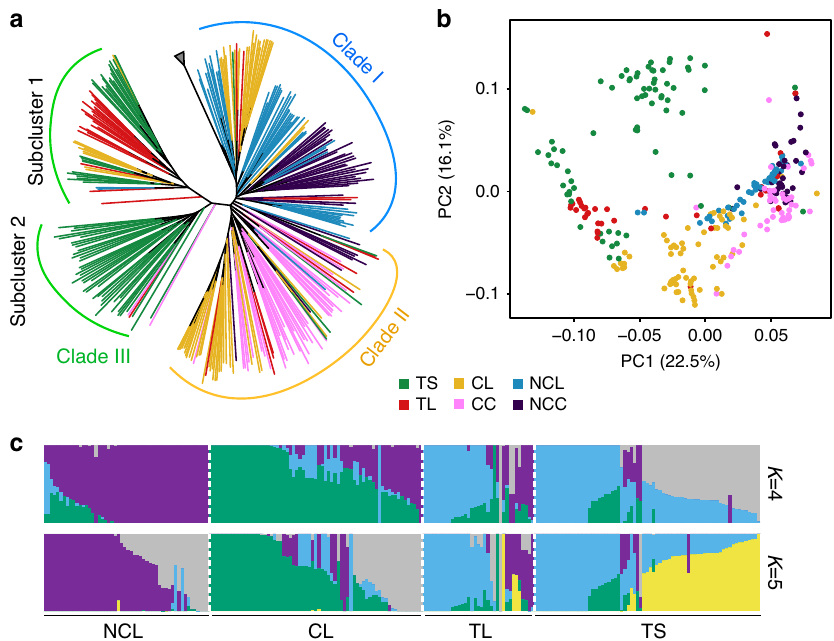
Fig. 3 Population structure analysis of resequencing wheat accessions. a A neighbor joining (NJ) phylogenetic tree of wheat resequencing samples using 364,856 high-con fi dence SNPs on subgenome D. Gray triangle, the outgroup, Aegilops tauschii , which is wild diploid progenitor for D genome in wheat. b PCA plot of resequencing samples based on SNPs in subgenome D. c Individual ancestry coef fi cients of resequencing accessions inferred using ADMIXTURE using SNPs in subgenome D. Each color represents one population. The length of each segment in each vertical bar represents the proportion contributed by ancestral populations. Source data are provided as a Source Data fi